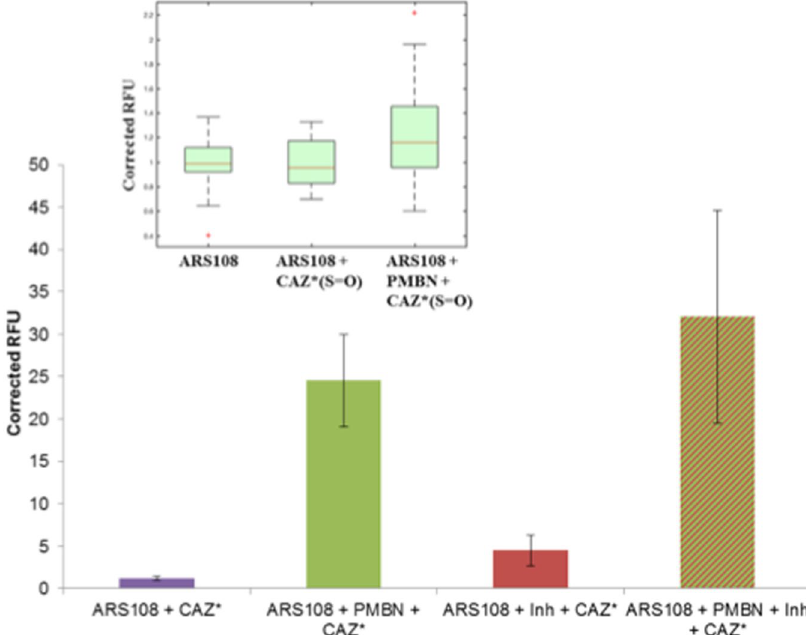
Figure 3. CAZ * and CAZ * (S = O) accumulation in individual bacterial cells (obtained after CAZ * and CAZ * (S = O) accumulation). Microspectrofluorimetry in individual bacteria (Excitation wavelength 372 nm, emission measured at 420–480 nm); corrected by the tryptophan signal and with negative controls (without CAZ * ). CAZ * and CAZ * (S = O) concentrations: 32 mg/L. PMBN: final concentration 102.4 mg/L. Inh: tazobactam + clavulanic acid 4 mg/L each. The columns with bars (standard deviations) corresponded to measurements carried out with about 100 cells. Insert: Accumulation of CAZ * (S = O) corrected by the background and with negative controls (without CAZ * (S = O)). Boxplot corresponded to measurements carried out with about 30